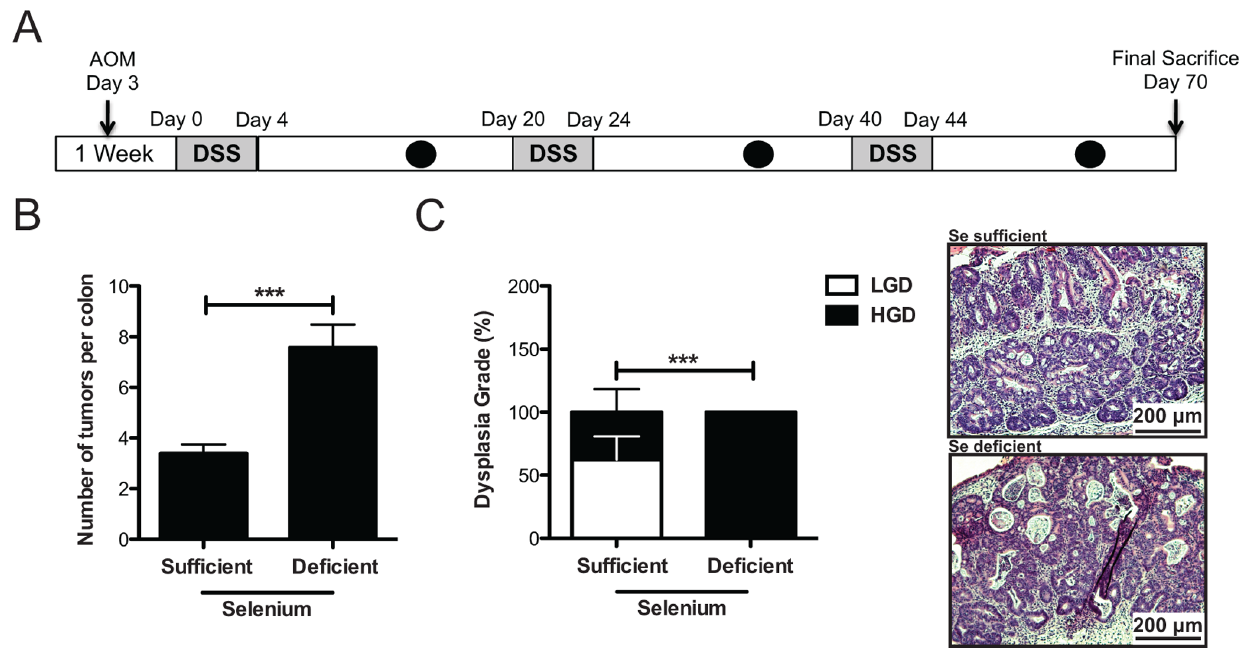
Figure 5. Selenium protects against tumor initiation and progression in inflammatory carcinogenesis. A. Schematic of the AOM/DSS CAC protocol. Mice are injected with AOM 4 days prior to beginning the first of three 4-day cycles of DSS. There are 16 days between each DSS cycle and mice are sacrificed 26 days after their last cycle of DSS. Black circles indicate periods at which mice are endoscopically analyzed. B. Selenium sufficient (n=18) and deficient (n=20) mice were subjected to the AOM/DSS protocol and tumor number was analyzed. *** P =0.0002. C. Tumors were analyzed (by pathologist M.K. Washington) for dysplasia grade (LGD=low-grade dysplasia, HGD=high-grade dysplasia) and quantified based on percent of tumors demonstrating each grade (left, HGD *** P , 0.0001, Fisher’s exact test). Representative H&E stained colons are displayed on the right.